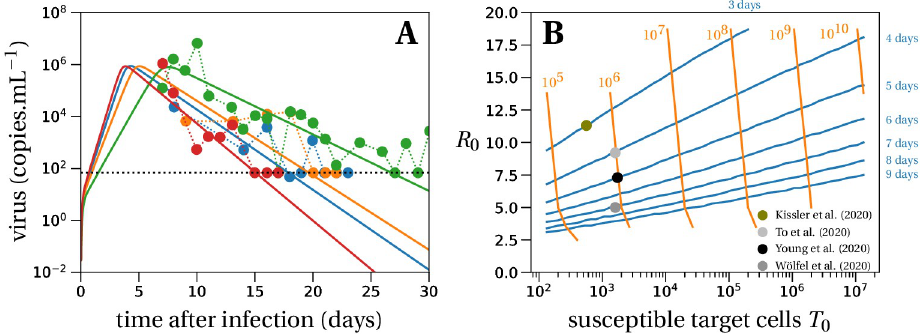
Fig 1. Deterministic within-host dynamics of SARS-CoV-2. (A) Model predictions using the target cell-limited model in four typical patients of ref. [31]. The estimated mean for the within-host R 0 of all patients from ref. [31] is 7.69. Parameter values are given in Table B in S1 Text. The dotted line depicts the detection threshold. (B) We plot the contour lines of the viral peak time (blue lines) and the number of virus particles at the viral peak per mL (orange lines) as a function of R 0 and the number of susceptible target cells T 0 . The lines are obtained by evaluating the set of differential equations in Eq (1) with different values of T 0 (x-axis) and R 0 (y-axis). The initial amount of virus particles per mL, V I (0) = 1/30, corresponds to 1 infectious virus particle in absolute numbers in the total upper respiratory tract, which we assume has a volume of 30 mL. The contour lines for viral loads (orange) stop if the viral peak is reached later than 20 days after infection, which can happen for low values of the within-host R 0 . The parameters of the model are set to: k = 5 day − 1 , c = 10 day − 1 , δ = 0.595 day − 1 , p = 11, 200 day − 1 , η = 0.001 and β = c δ R 0 /( T 0 ( η p − δ R 0 )) day − 1 . Dots depict averages of some data sets from Table